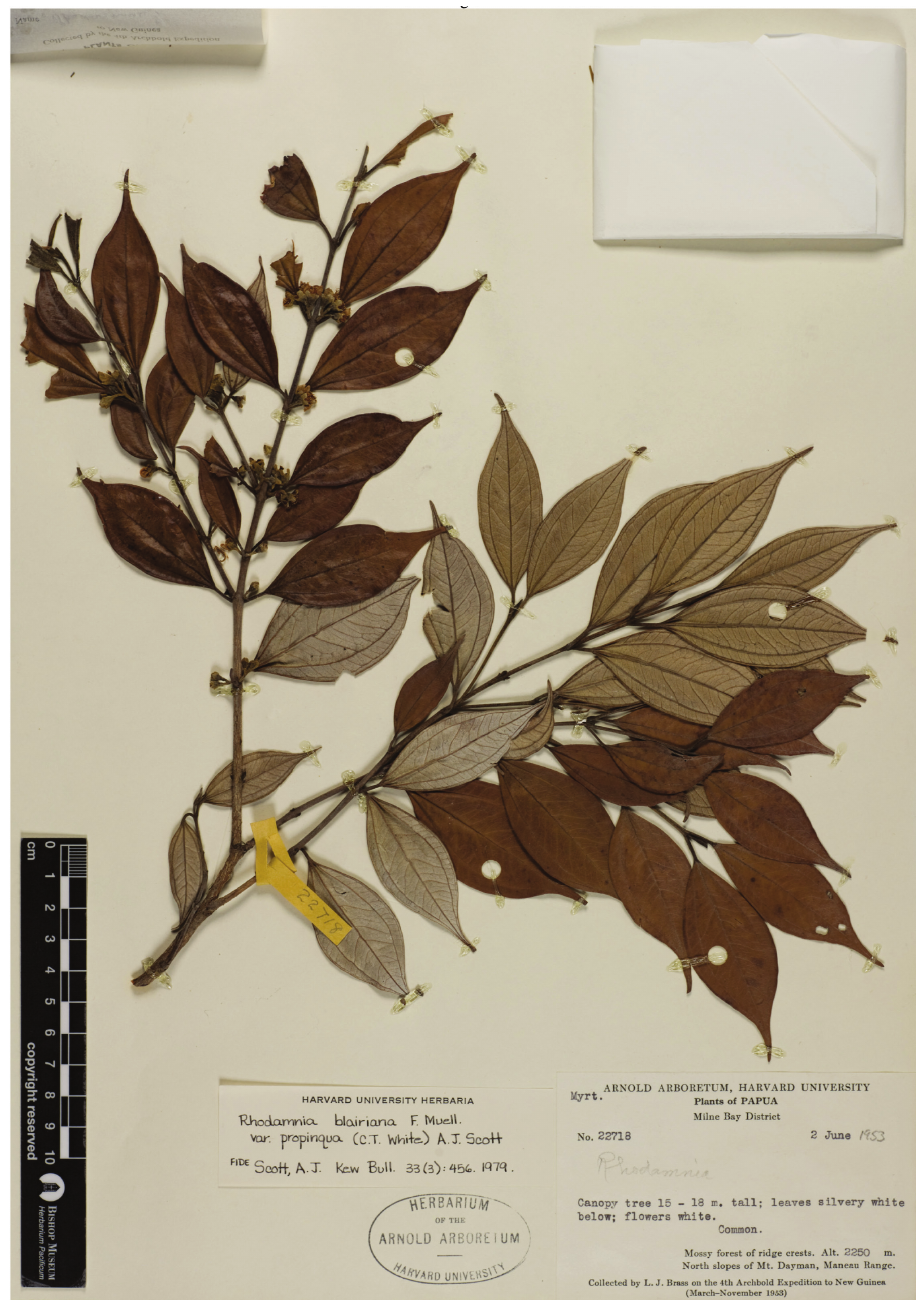
Figure 3. Rhodamnia daymanensis N. Snow. Photo of the holotype at A ( L. J. Brass 22718